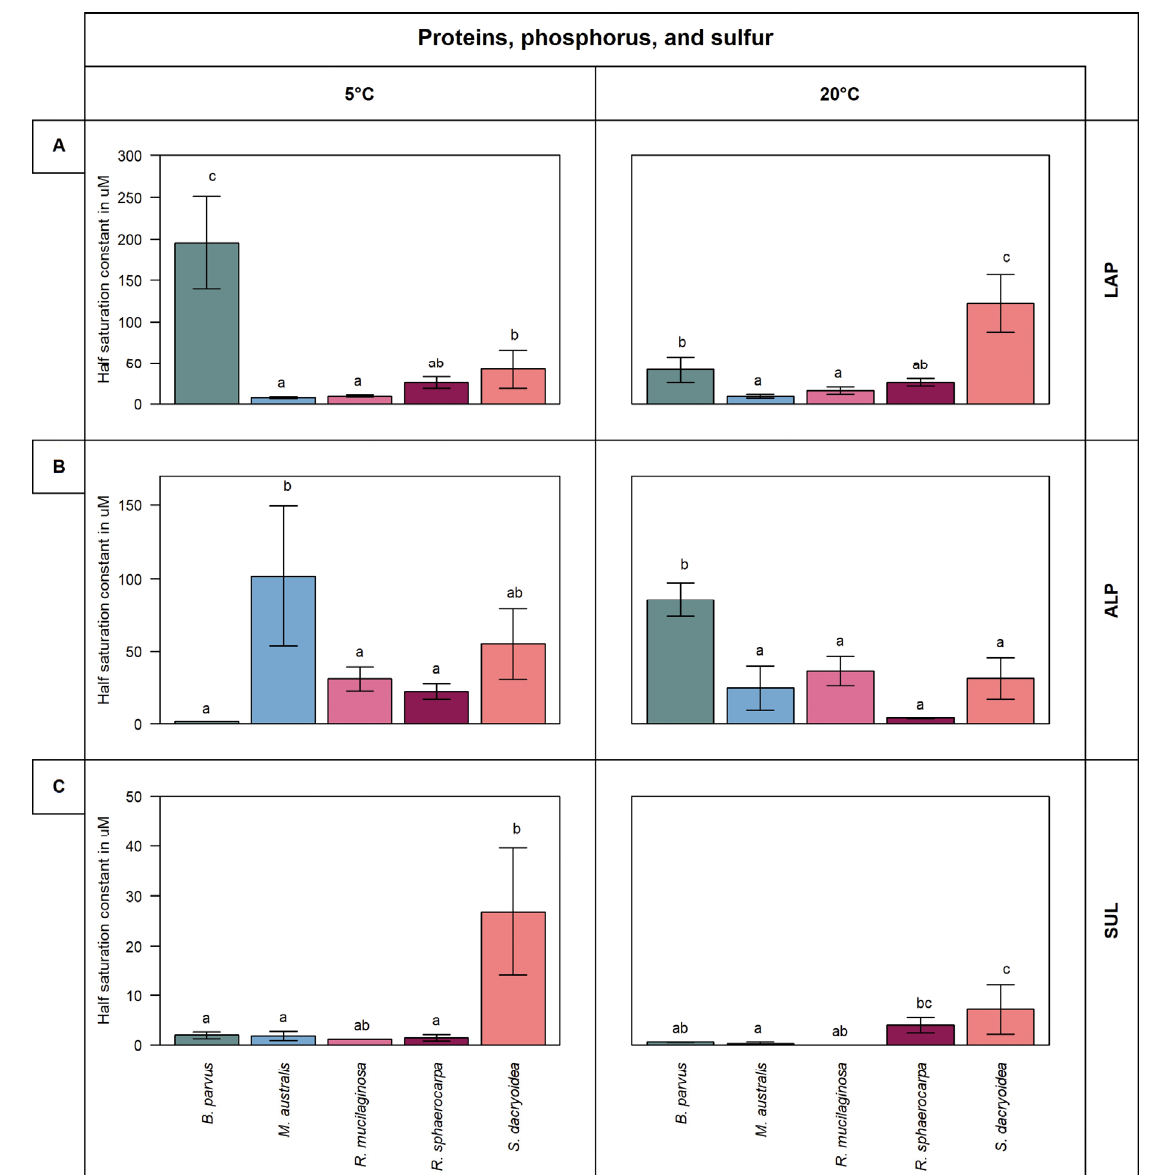
Figure 4. K m in µ M obtained from the total enzymatic activity for the substrates representing proteins, phosphorus, and sulfur, such as ( A ) leucine aminopeptidase (LAP), ( B ) alkaline phosphatase (ALP), and ( C ) sulfatase (SUL) of the five marine fungal isolates ( B. parvus , M. australis , R. mucilaginosa , R. sphaerocarpa , and S. dacryoidea ). Measurements were performed at 5 ◦ C and 20 ◦ C in the exponential phase. According to Tukey’s HSD, bars denoted by a different letter (a, b, and c) are significantly different ( p < 0.05), whereas bars denoted by a common letter (ab and bc) are not significantly